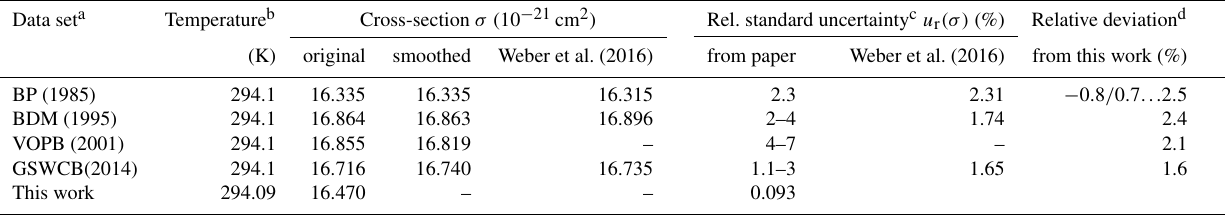
Table 5. Comparison of absolute high-resolution absorption cross-section data of ozone at 325.126nm in vacuum (325.033nm in air). Smoothed data were obtained from applying a Savitzky–Golay filter of order 2 over the range of 0.1nm. Data set